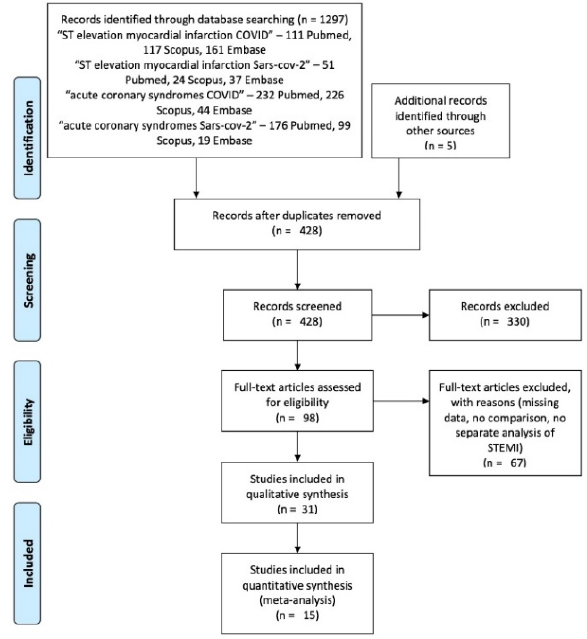
Figure 1. PRISMA flow chart of the selection process.